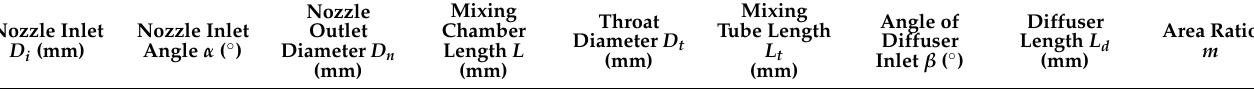
Figure 1. Schematic diagram and main parameters of the jet pump. Table 1. Geometric parameters of the jet slurry pump.